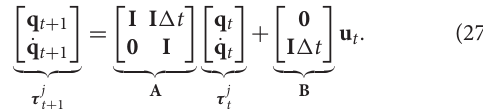
Algorithm 3 : Learning to avoid obstacles with